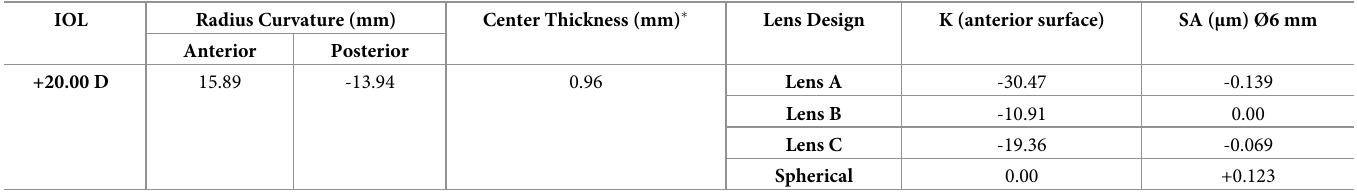
Table 3. Parameters of the IOLs used in the study.